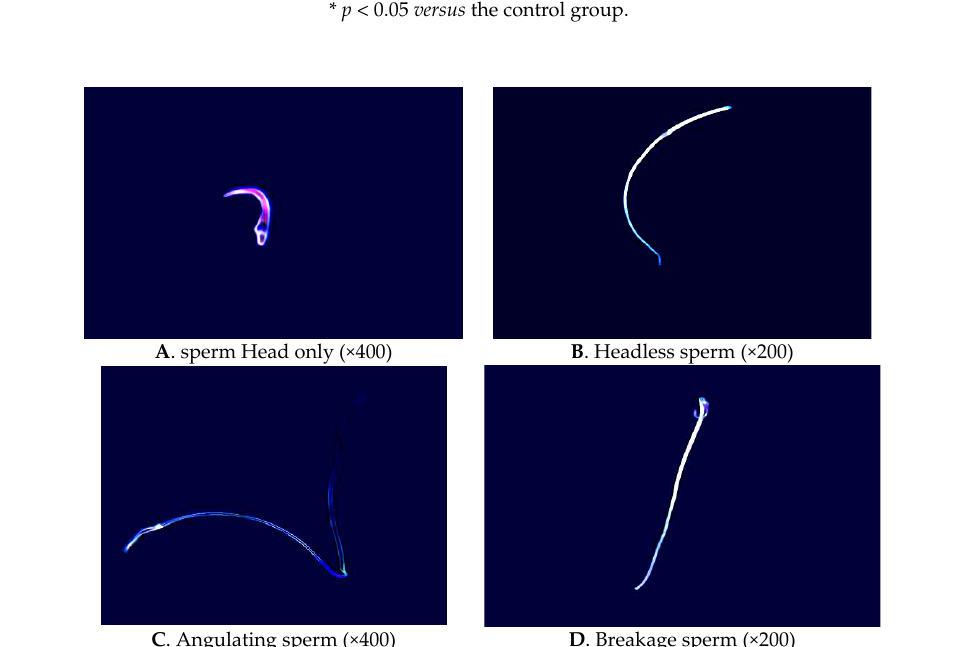
Figure 2. The structure of rat epididymal teratosperm under phase contrast microscope. ( A ) sperm Head only; ( B ) Headless sperm; ( C ) Angulating sperm; ( D ) Breakage sperm.